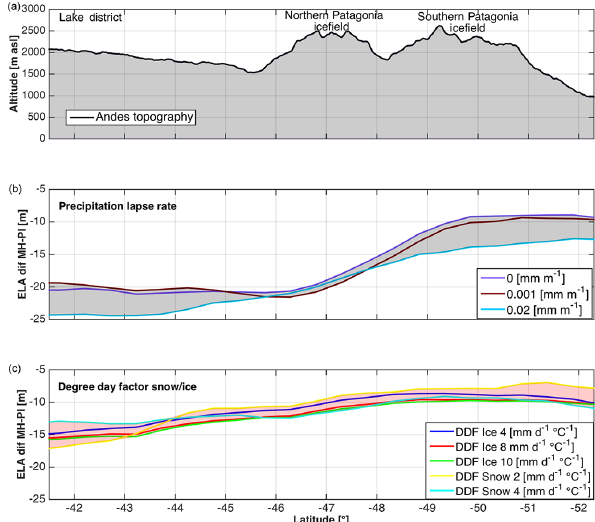
Figure 8. Sensitivity of ELA differences in the Patagonian Andes to precipitation lapse rate and DDF of snow and ice. (a) Latitudinal topography profile of Patagonia (SRTM 1km), ( b ) ELA differences sensitivity to precipitation lapse rate, and (c) ELA difference sen- sitivity to DDF of snow and ice. Grey and pink areas in (b) and (c) represent the range in ELA differences between MH and